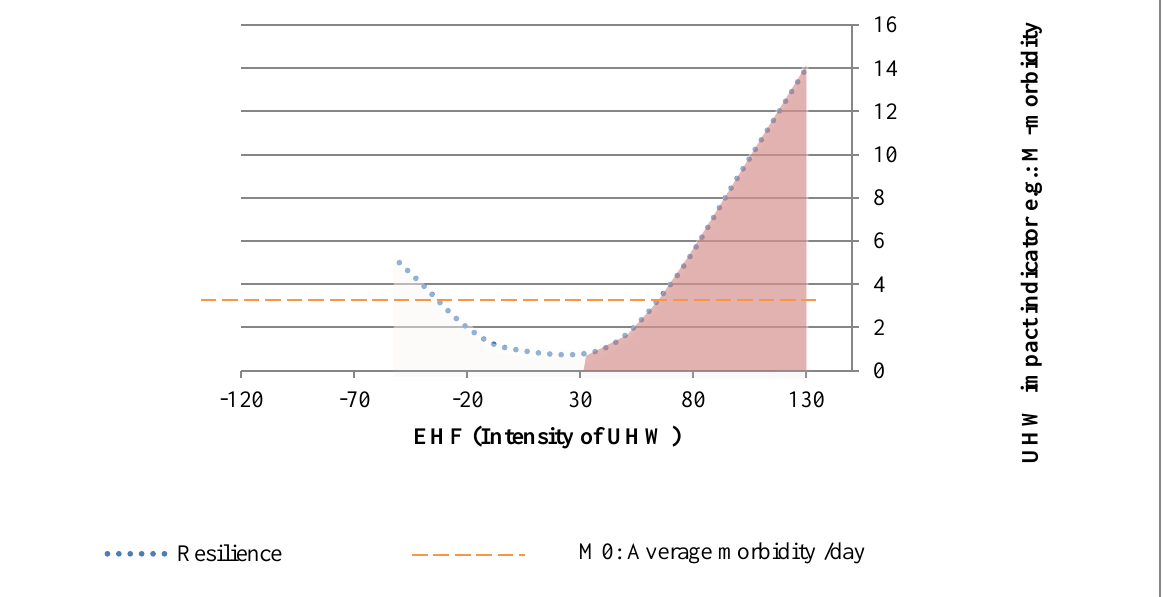
Figure 4. A hypothetical graph about precinct